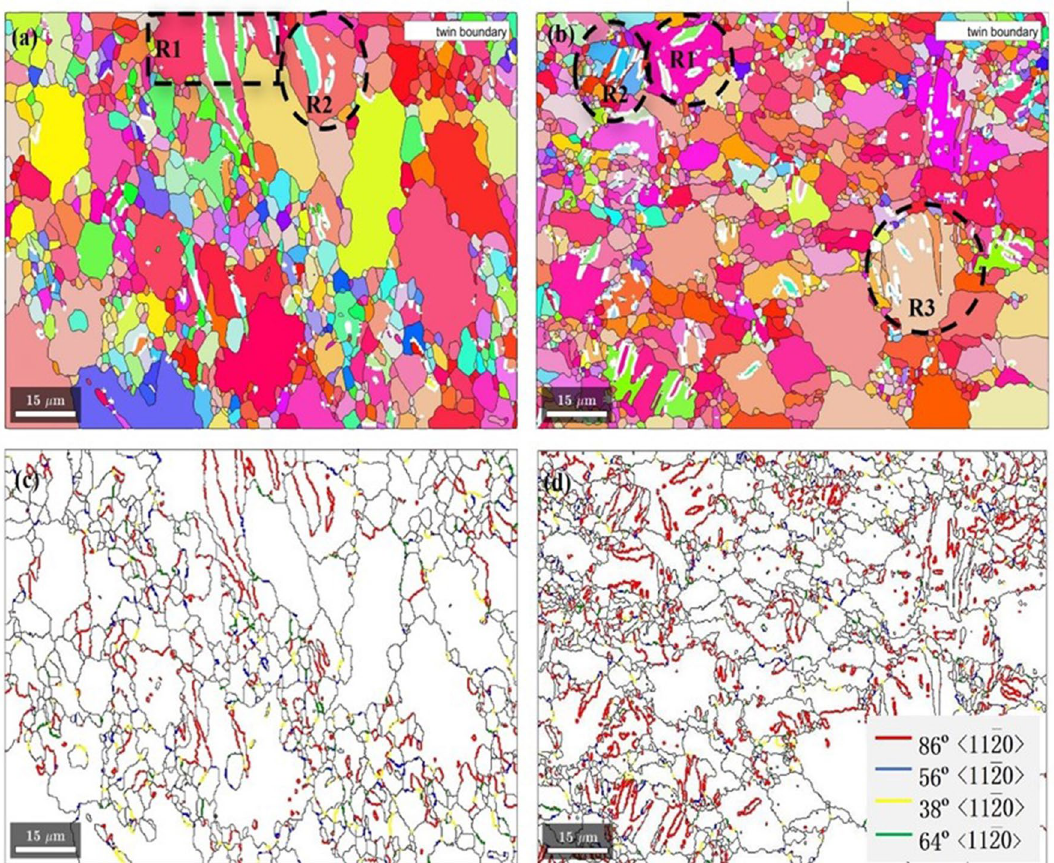
Figure 6. Twinning distribution of Mg–2Y–0.6Nd–0.6Zr alloy after ECAP under different rolling temperatures. ( a ), ( c ) ECAP4Passes + room temperature, ( b ), ( d ) ECAP4Passes + ultra-low